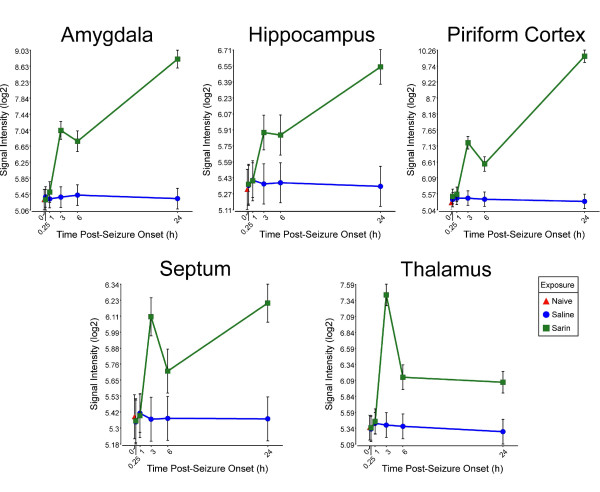
Sarin-induced seizure up-regulates the expression of IL-6 in all five brain regions examined. Tissues were collected at 0.25, 1, 3, 6, and 24 h after seizure onset and processed for oligonucleotide microarray analysis. IL-6 expression peaked at 3 h and decreased at 6 h in all brain regions. Expression then increased at 24 h after seizure onset in the amygdala, hippocampus, piriform cortex, and septum. IL-6 expression appeared to level off after 6 h in the thalamus.